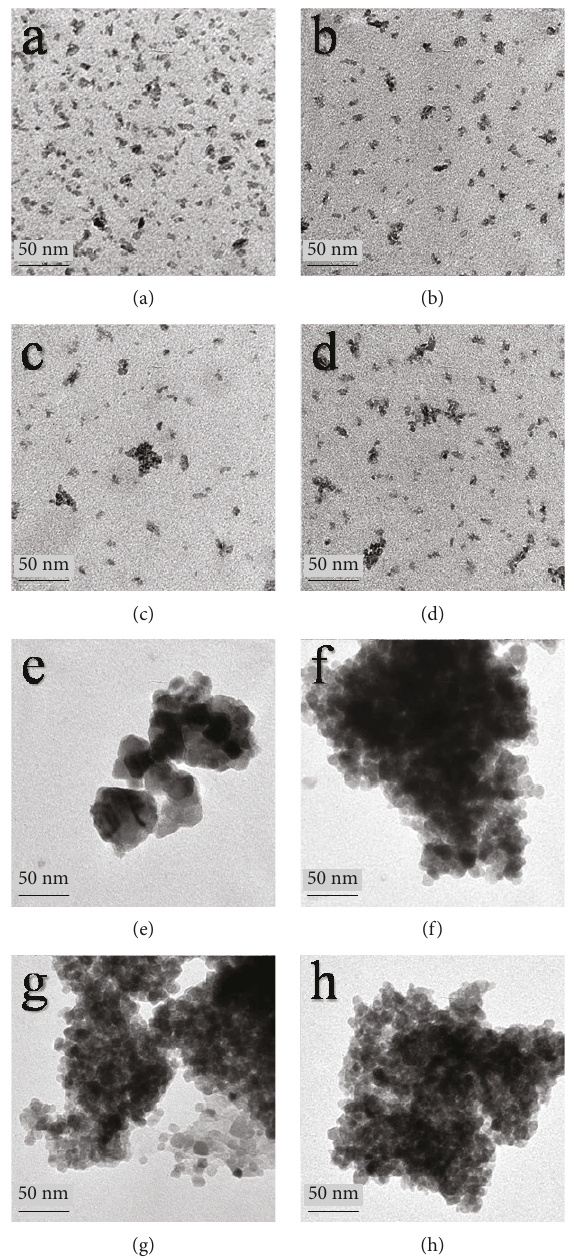
Figure 1: TEM images of S0, S3, S5, and S10 before (a – d) and after (e – h) thermal